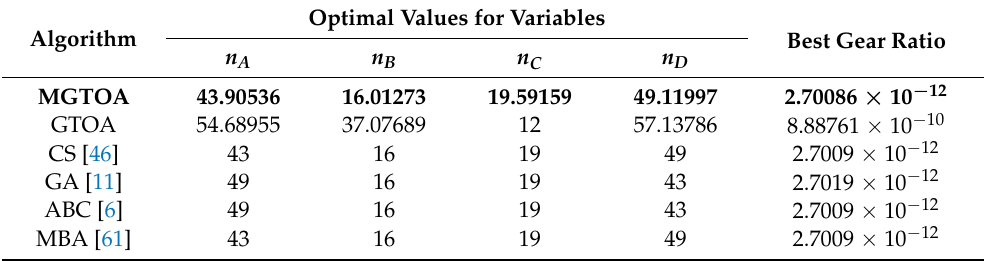
Table 15. Experimental results of gear train design.